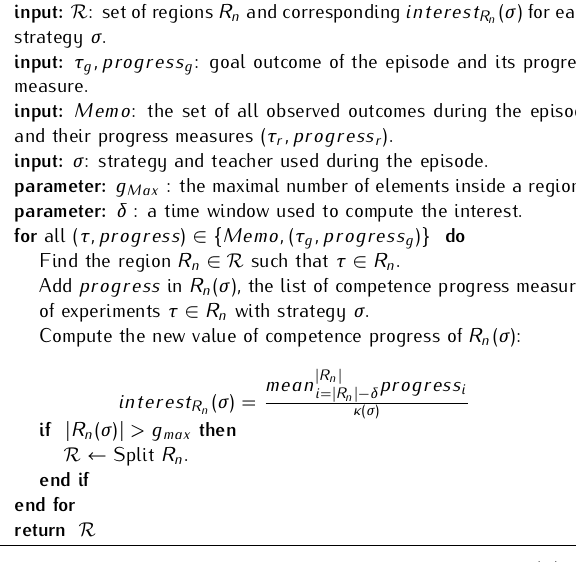
Algorithm 2 [ R ] = Update Outcome and Strategy Interest Mapping ( R ,Memo,τ g ,progress g ,σ